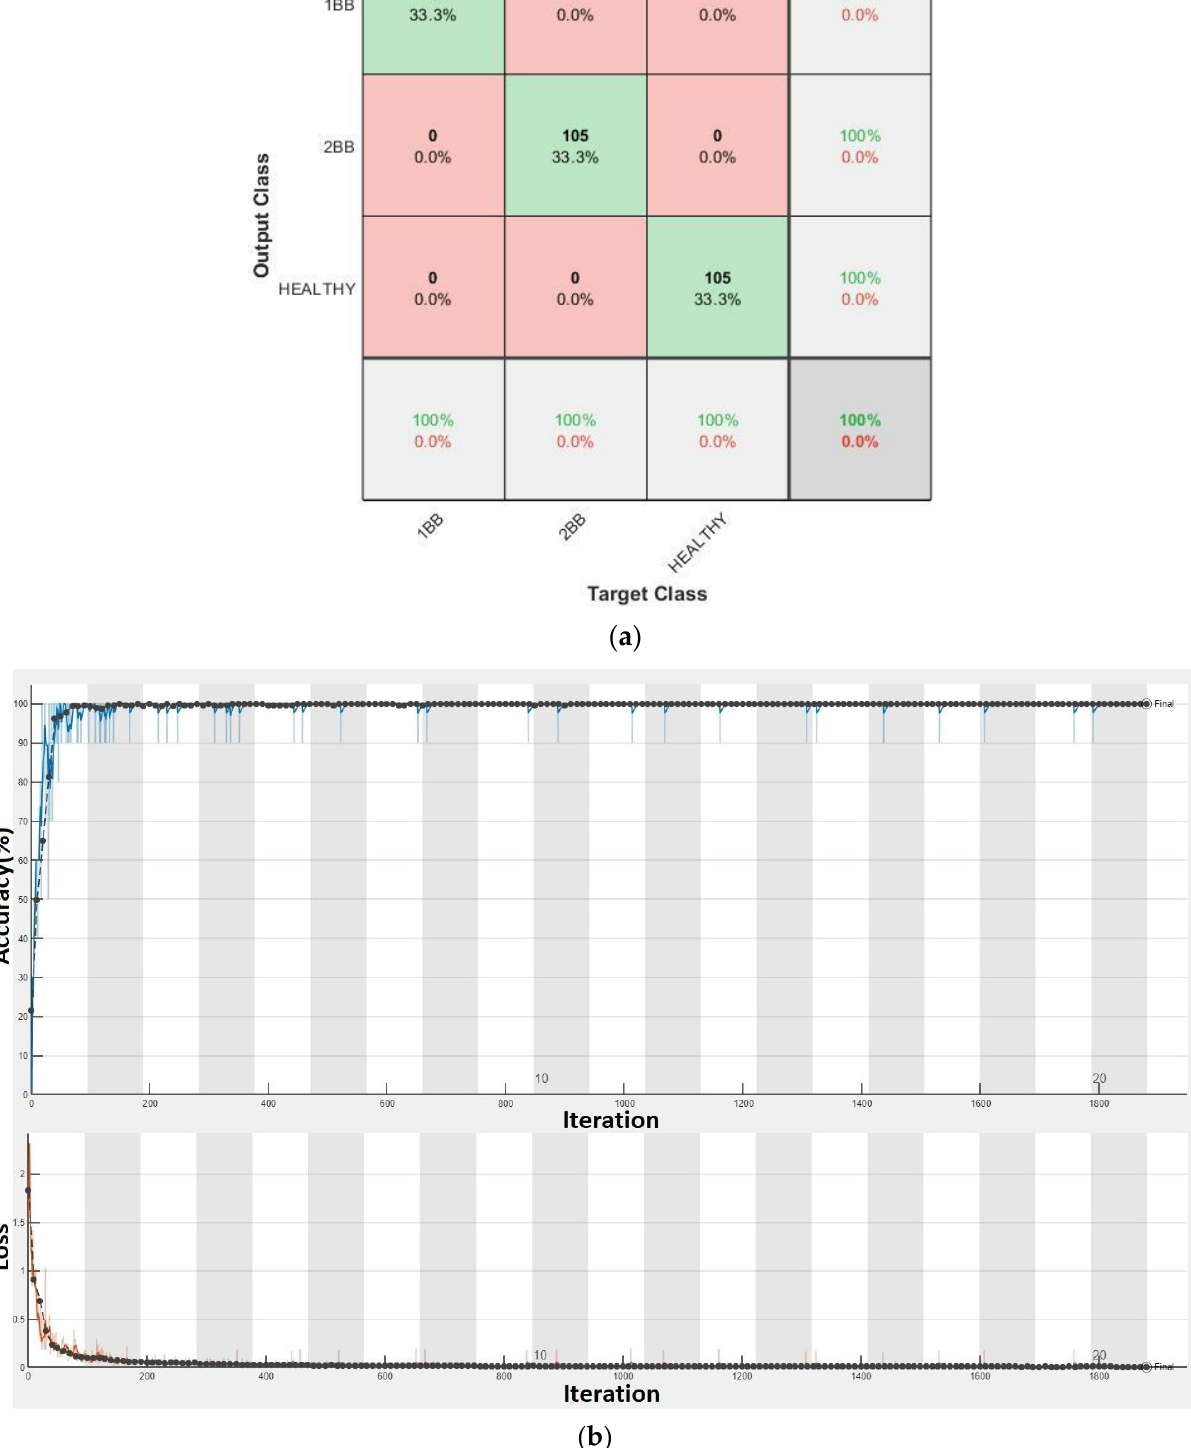
Figure 15. Results for Schneider soft starter: ( a ) Confusion matrix. ( b ) Training progress.